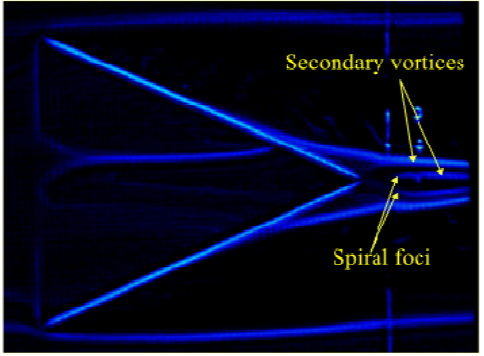
Figure 12. Surface flow visualization result of MR80 after being manipulated, from Saad et al. [22] (Reprinted with permission of the American Institute of Aeronautics and